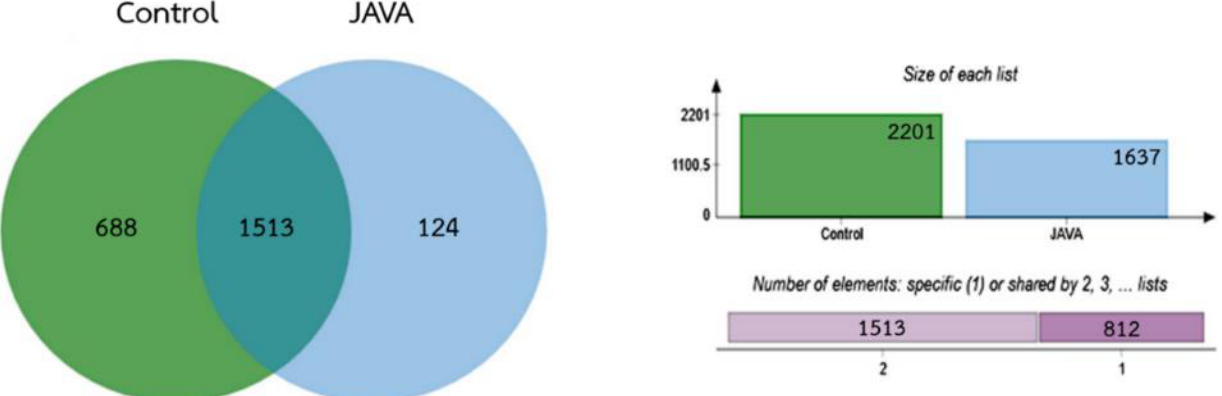
Figure 5. Venn diagram showing the number of C. neoformans proteins identified from untreated control group and r-javanicin treated group (0, 4, 8, 16, and 24 h), analyzed by LC-MS/MS. Left part shows the protein counts of shared (1513 proteins) and un-shared regions between yeast cell control (Control; 688 proteins) and javanicin treated C. neoformans (JAVA; 124 proteins). Charts on the top right show the size of protein clusters in control (green) and peptide treated group (blue) while the lower right is the cumulative numbers of shared (light purple) and un-shared proteins (purple) based on Venn diagram.